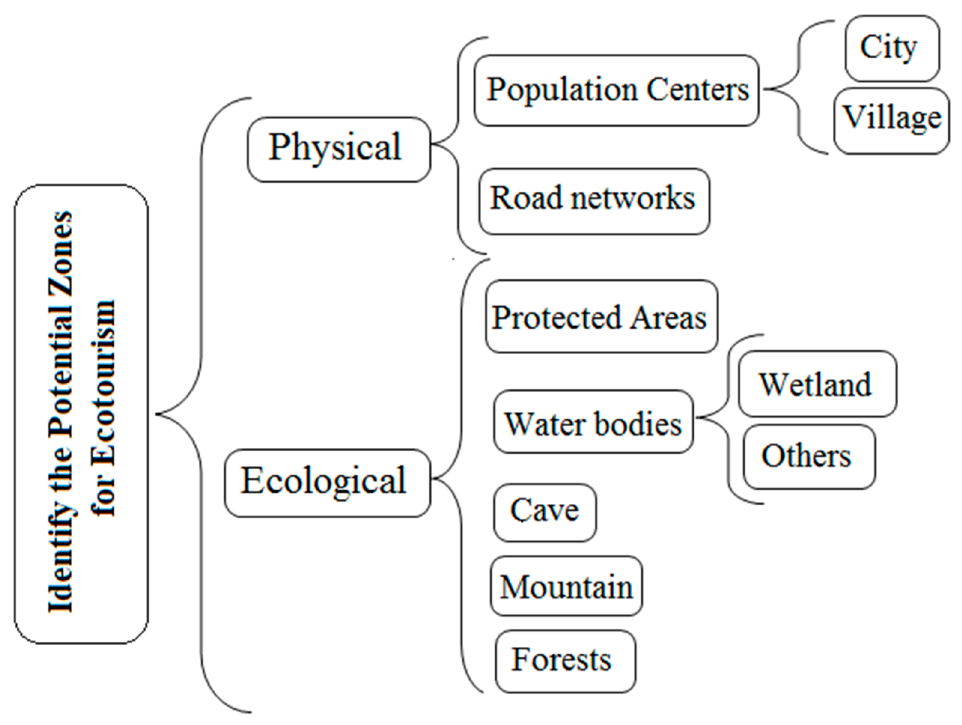
Figure 4. Selected criteria and sub-criteria for identifying the potential zones for ecotourism development.